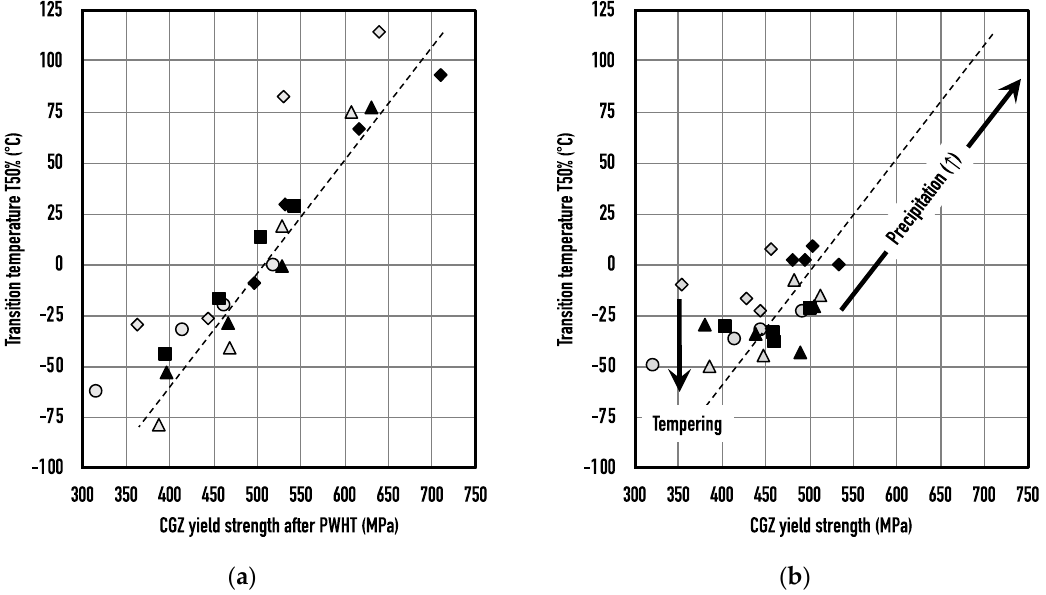
Figure 10. Influence of post-weld heat treatment (PWHT) on strength and toughness: ( a ) DBTT (T50%) vs. yield strength after a relaxation treatment at 560 °C for 30 min; ( b ) DBTT (T50%) vs. yield strength before relaxation treatment (same data as Figure 7b, same trendline as Figure 9a).